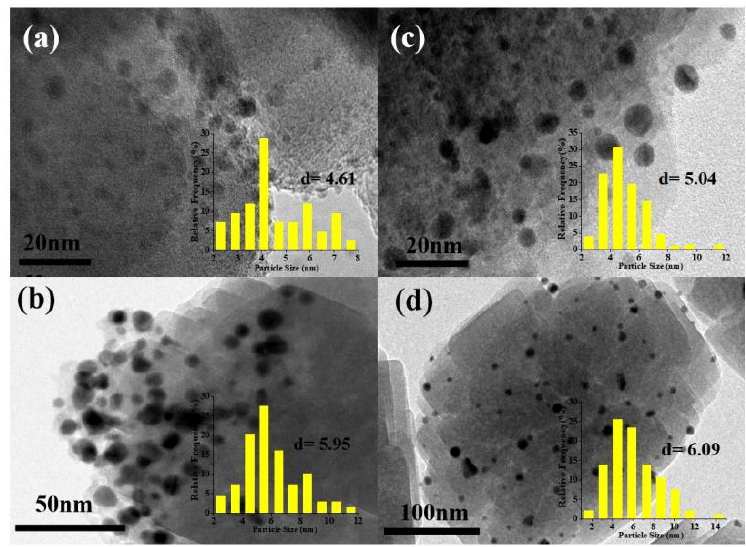
Figure 8. The TEM images and size distribution of Au/TS-1 catalysts: ( a ) Au/TS-1-wash-H 2 , ( b ) Au/TS-1-wash-O 2 , ( c ) Au/TS-1-H 2 and ( d ) Au/TS-1-O 2 .